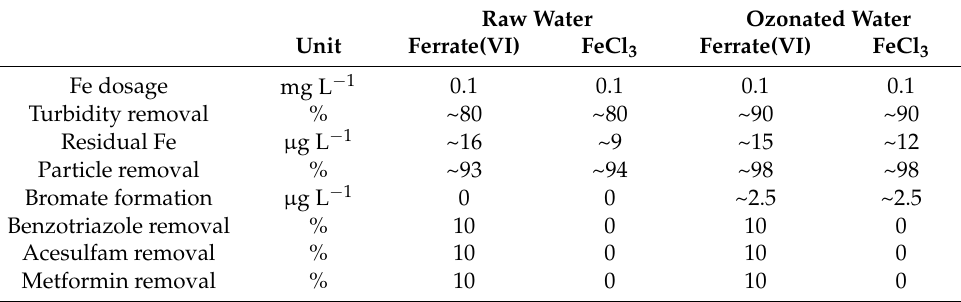
Table 3. Comparative performance of ferrate(VI) and FeCl 3